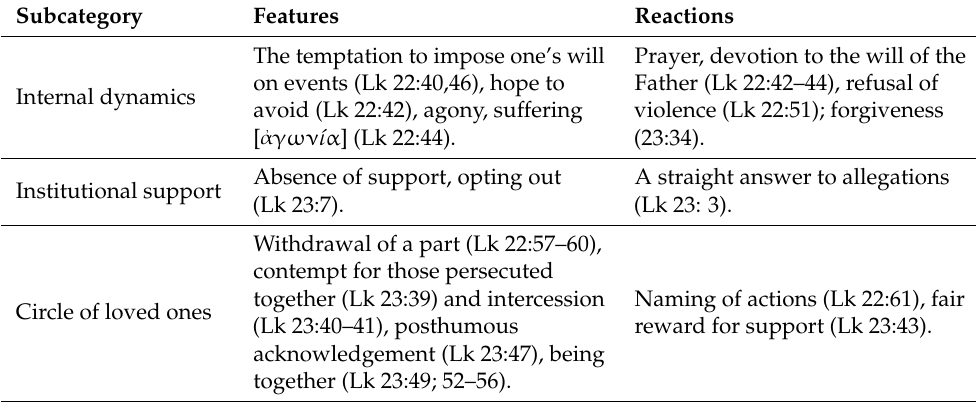
Table 6. Behavioural characteristics and internal dynamics of the environment that can provide assistance.